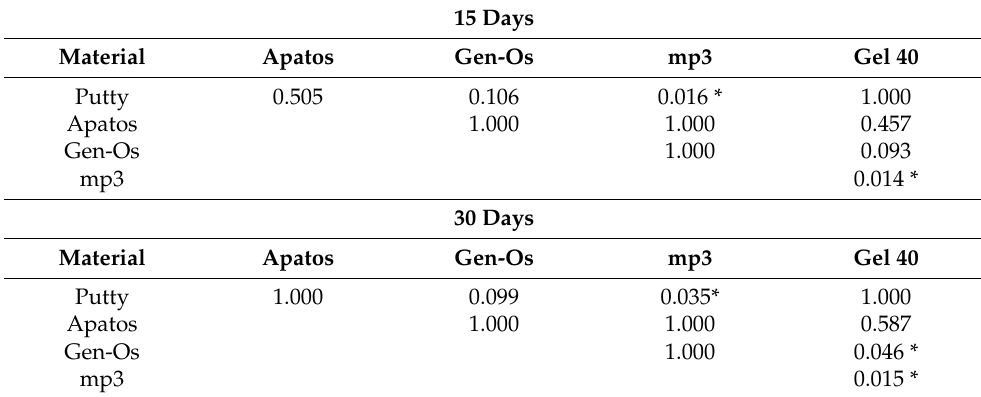
Table 2. Group comparison regarding new bone formation percentage at both evaluated timepoints.